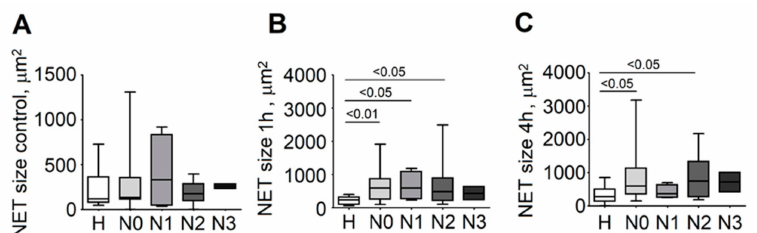
Figure 3. Neutrophils from early N stages of HNC release NETs significantly faster and to a greater extent. ( A ) Quantification of spontaneous NET release by di ff erent N stages of HNC neutrophils. ( B ) Quantification of early NET release. ( C ) Quantification of late NET release. Neutrophils were